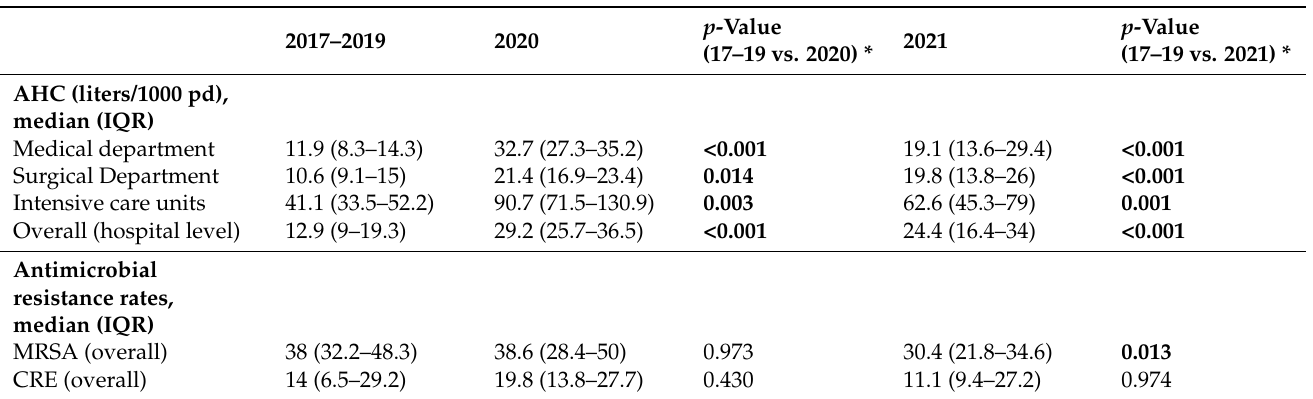
Table 1. Alcohol-based handrub consumption (AHC), and methicillin-resistant Staphylococcus aureus (MRSA) and carbapenem-resistant Enterobacteria (CRE) rates among 27 hospitals in